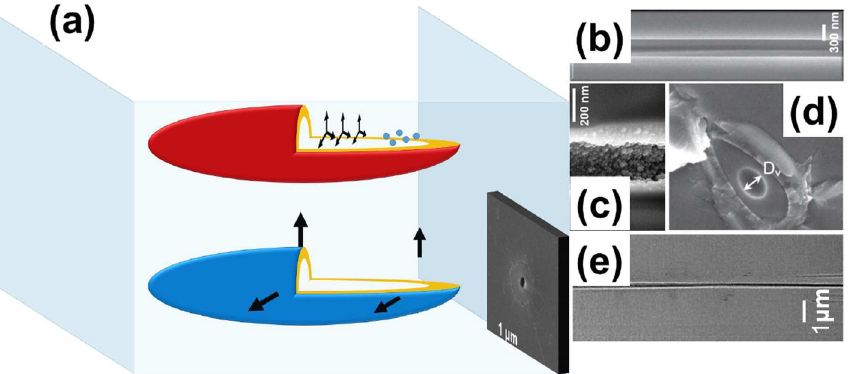
Figure 8: (a) Illustrative concepts for shock-driven cavitation in the solid phase and stress-driven cavitation in the liquid phase. (b) Fs-pulse induced cavity in sapphire with nondiffractive beams. Reprinted with permission from a study by Rapp et al. [109] ©Springer-Nature. (c) Ps-pulseinducedcavityinsapphirewithnondiffractivebeams.ReprintedwithpermissionfromastudybyRappetal.[109]©Springer-Nature. (d) Fs-pulse induced cavity in sapphire with Gauss beams. Reprinted with permission from a study by Juodkazis et al. [106] ©American Physical Society. (e) Fs-pulse induced cavity in fused silica with nondiffractive beams